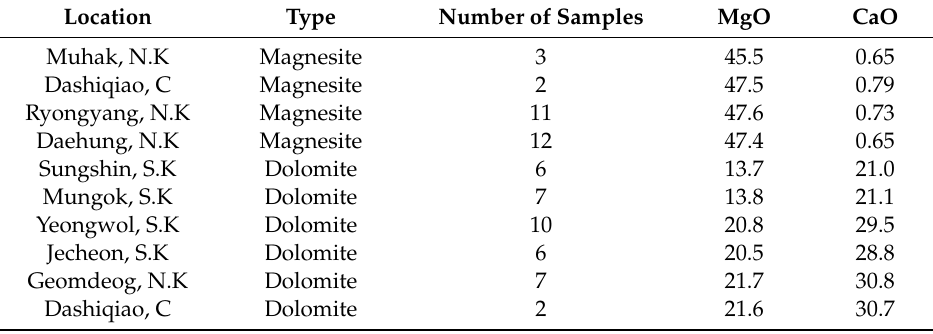
Table 3. The average MgO and CaO contents of representative magnesite and dolomite samples based on X-ray fluorescence (XRF)